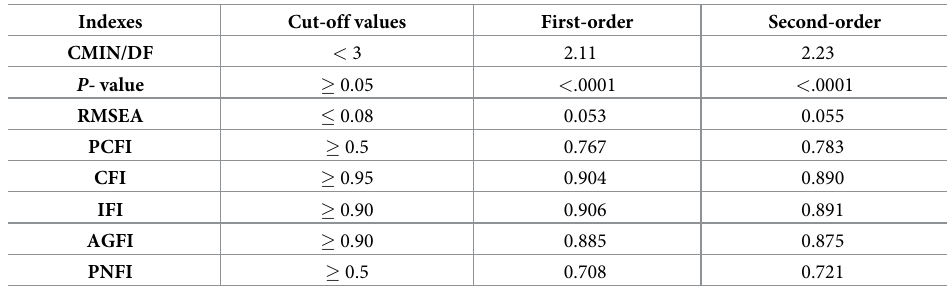
Table 3. Fitness indices in the first and second-order factor